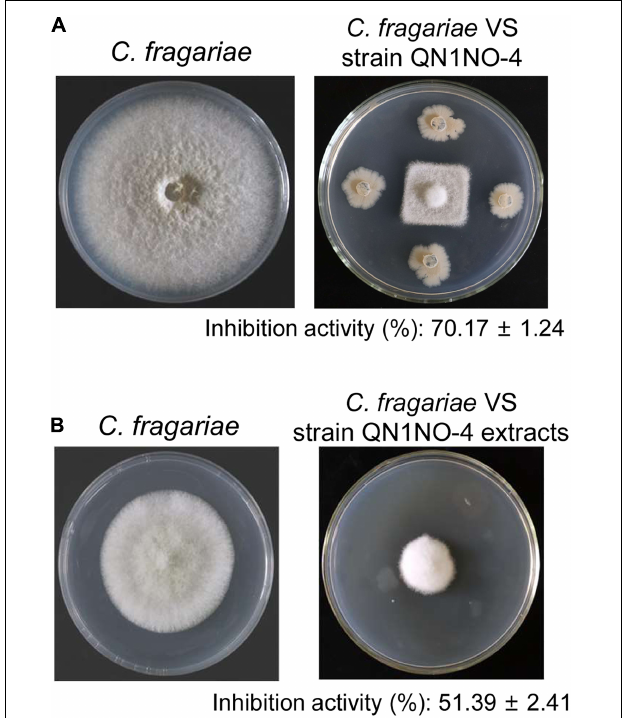
FIGURE 1 | Antifungal activity of strain QN1NO-4 and its extract against C. fragariae of strawberry. (A) In vitro inhibition activity of strain QN1NO-4 on mycelial growth of C. fragariae . (B) Effects of extract isolated with 100% of methanol on mycelial growth of C. fragariae